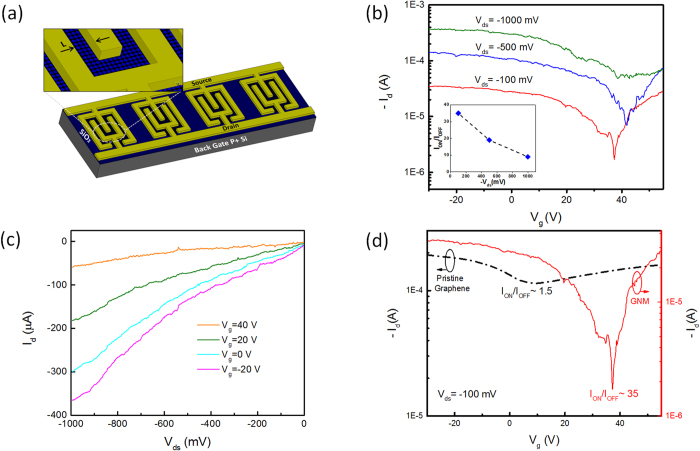
Transfer characteristics of graphene nanomesh.(a) A schematic representation of the GNM-FET. The graphene mesh structure with an average neck width of ~10 nm was fabricated on heavily doped silicon substrate coated by 285 nm-thick SiO2 layer as the gate dielectric. The channel length L and width W of the GNM-device are 14 μm and 2 mm, respectively. (b) Id versus gate voltage (Vg) recorded at different source-drain voltages obtained at room temperature. (c) Source-drain current (Id) versus source-drain voltage (Vds) recorded at different gate voltages at room temperature. (d) Comparison of Id−Vg for bulk (black dashed line) and GNM-devices (red solid line) at Vds = −1 mV at room temperature. The current for bulk graphene-device and GNM-device are specified on the left and right axis, respectively.